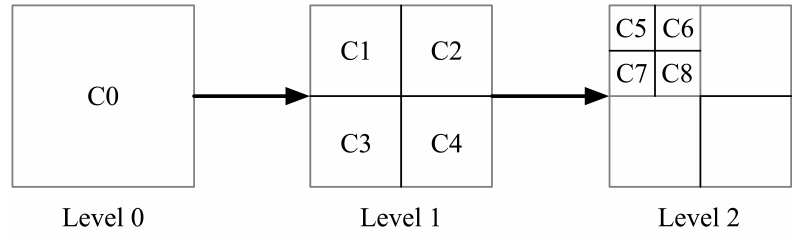
Figure 7. Diagram illustrates the process of quadtree node